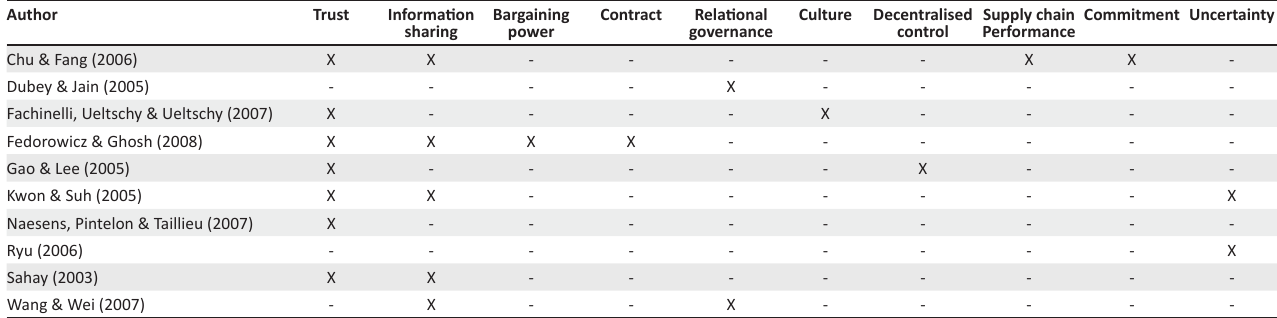
TABLE 1: Supply chain concepts (content analysis).